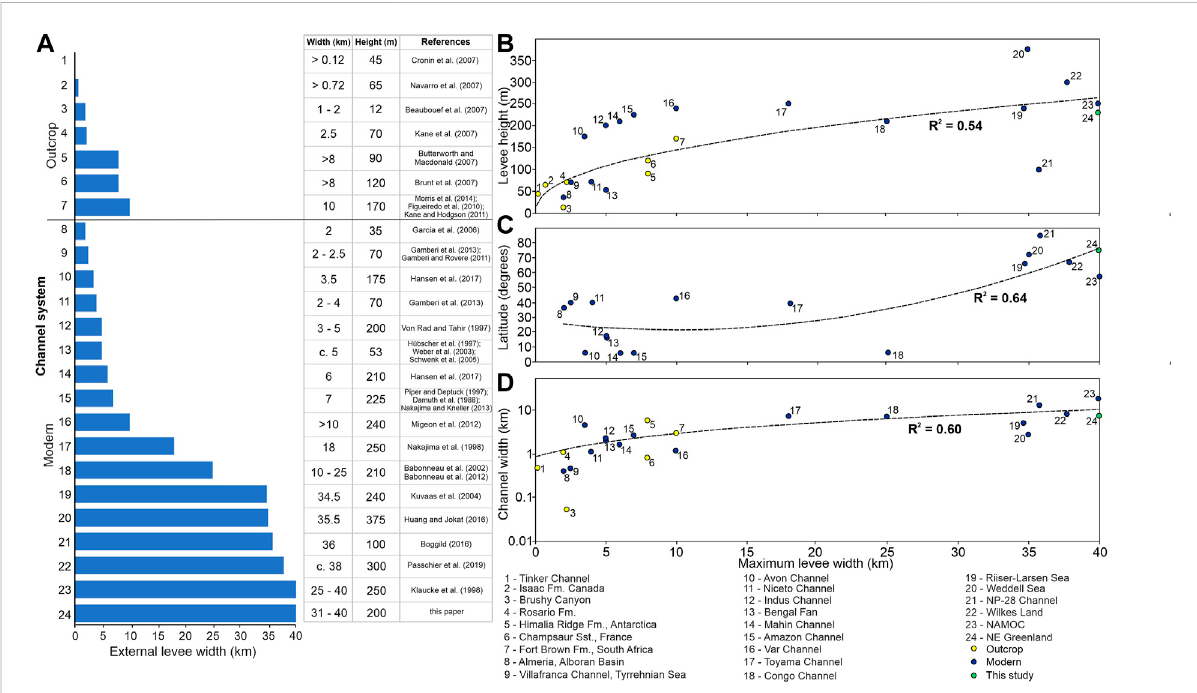
FIGURE 10 (A) Comparison of external levees from 24 systems (ancient and modern), adapted and extended from Hansen et al. (2015), showing the abnormallylargesizeofleveesassociatedwiththissystem.Tonormalisedata,widthandheightarecomparedin (B) .Itshouldalsobenotedthatlevee heightvaluesforoutcropexampleshavenotbeendecompactedsotheseareminimumvalues.Latitudeandwidthofmodernsystemsarecompared in (C) , displaying the correlation between levee width and latitude. Due to the unreliable estimates of palaeolatitude for ancient systems, only modern systems have been used for this comparison. (D) Shows channel width versus levee width for the systems included; note a change to logarithmic scale to account for a wide range of channel widths (Damuth et al., 1988; Hübscher et al., 1997; Piper and Deptuck, 1997; Von Rad and Tahir, 1997;Nakajimaetal., 1998;Babonneau etal.,2002;Weberetal., 2003;Schwenk etal.,2005;García etal.,2006;Beaubouefetal., 2007;Brunt et al., 2007; Butterworth and Macdonald, 2007; Cronin et al., 2007; Kane et al., 2007; Navarro et al., 2007; Figueiredo et al., 2010; Gamberi and Rovere, 2011; Babonneau et al., 2012; Migeon et al., 2012; Morris et al., 2014; Boggild,